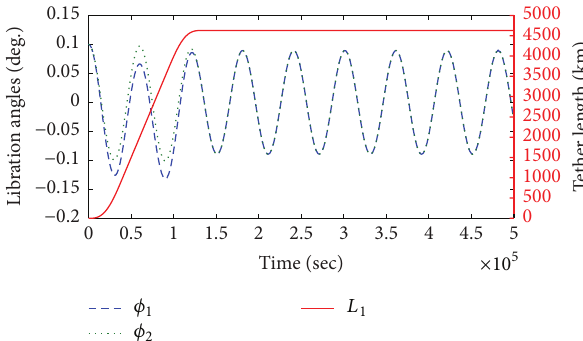
Figure12:Librationangles 𝜙 1 (𝑡) and 𝜙 2 (𝑡) asfunctionsoftimebased on the prescribed function 𝐿 1 (𝑡) on a circular orbit with zero initial conditions.